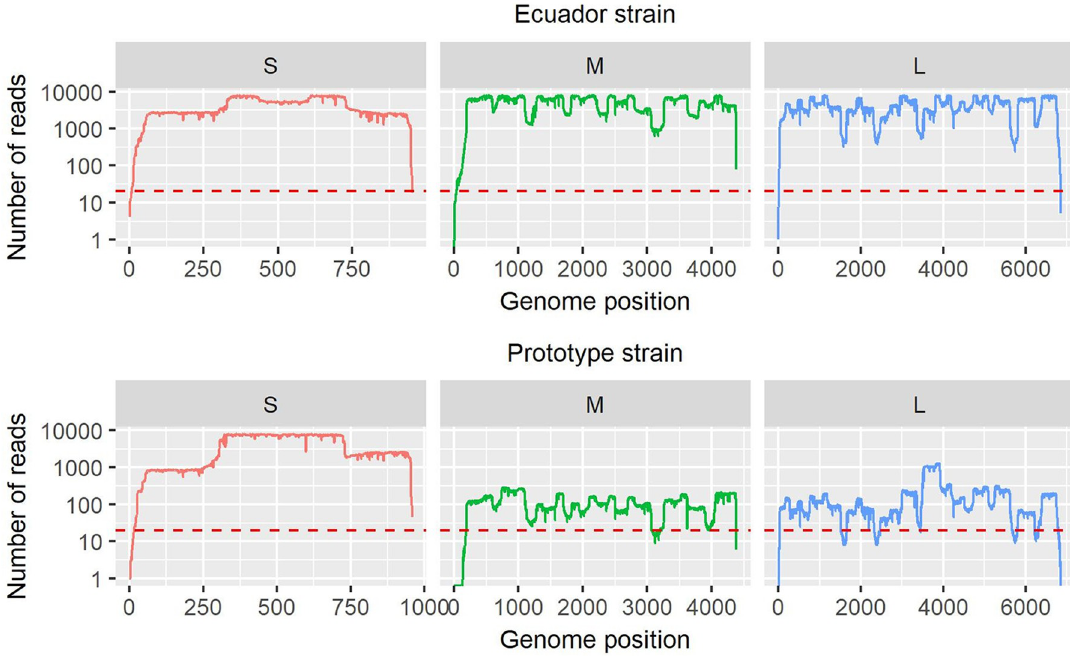
Fig 4. Genome coverage of two OROV strains (Ecuadorian strain OROV/EC/Esmeraldas/087/2016 Genbank MF926352.1— MF926354.1, and prototype strain Genbank KP026179.1—KP026181.1), sequenced using a MinION (Oxford Nanopore), from multiplex tiling RT-PCR amplicons. Plots are separated by genome segment (S, M, L). Red dashed line indicates 20x coverage.